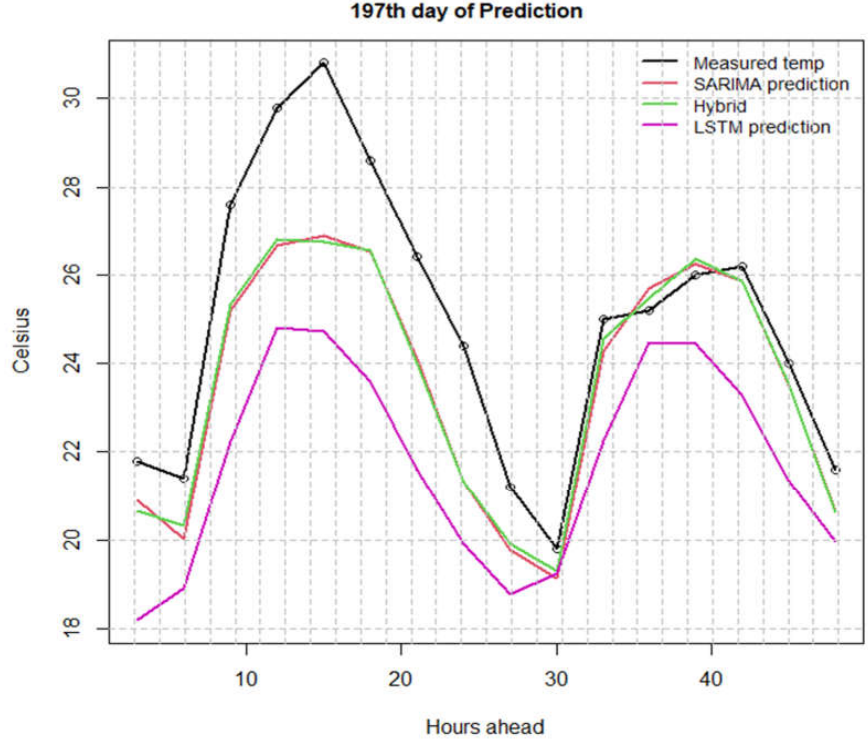
Figure 8. Comparison of SARIMA, LSTM and hybrid with real data on temperature example for 2-day prediction horizon in June; example with very big MAE.